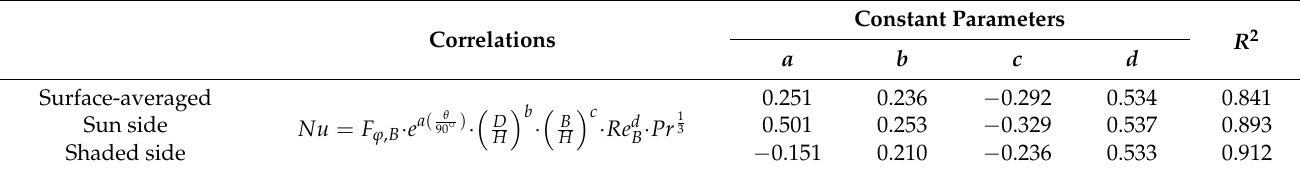
Table 4. Calculation for F φ,B to describe the wind direction effect on Nu at the louver blinds. Correlations